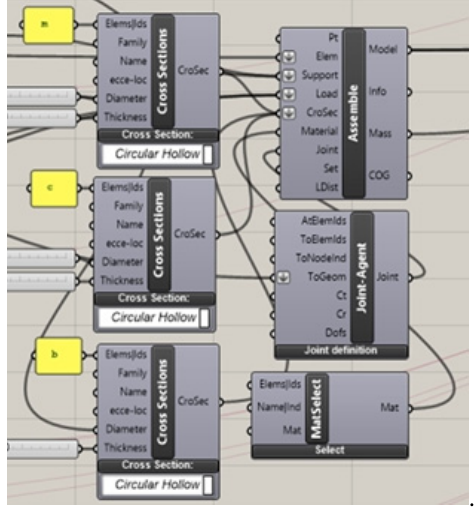
Figure 6. The fragment of the Karamba 3D script for structural analysis.